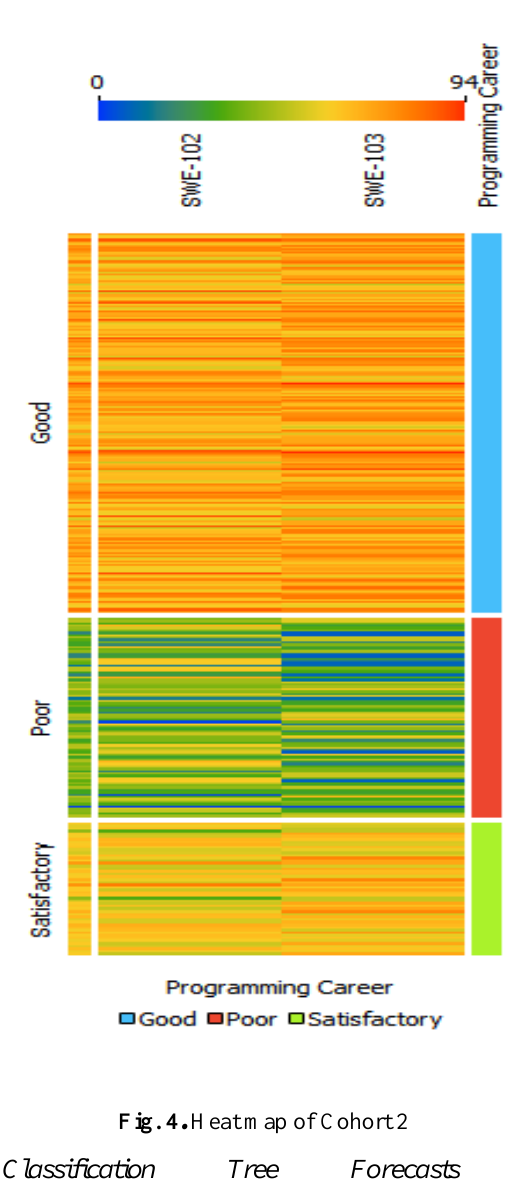
Fig. 3 . Heat map of Cohort 1